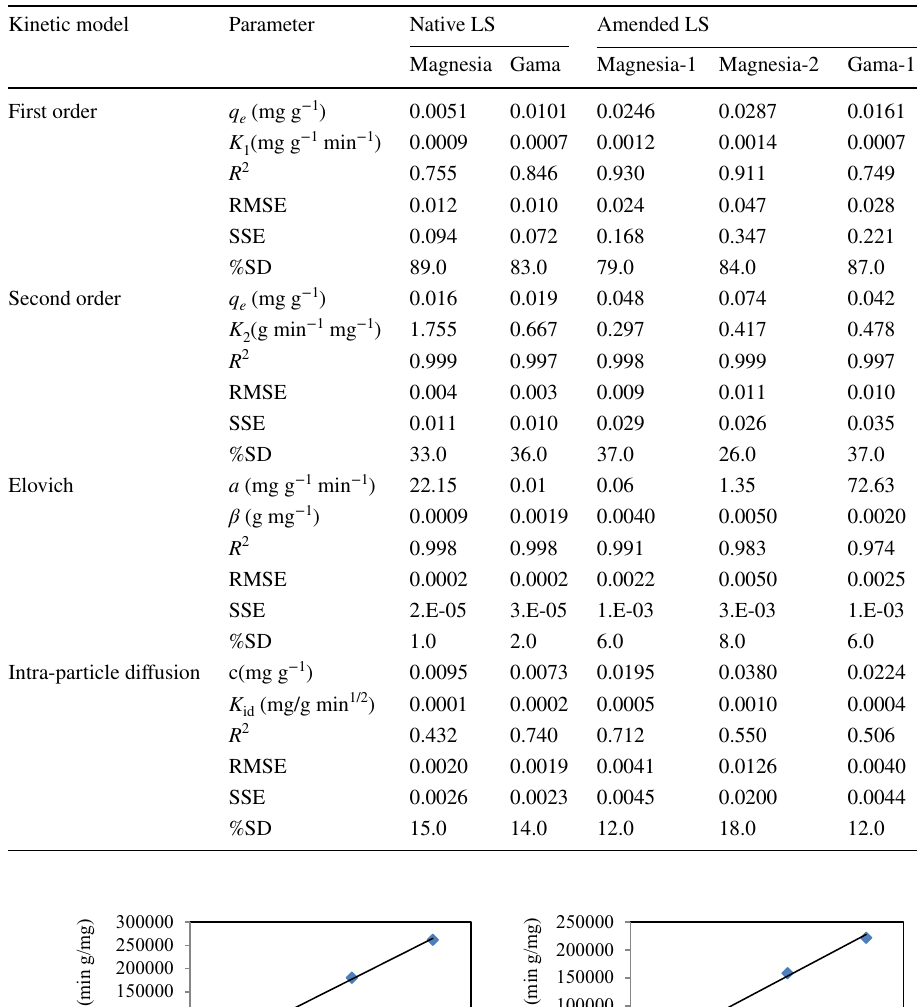
Fig. 6 Second-order lineariza- tion for F − adsorption onto a Magnesia b Gama c Magnesia-1 d Gama-1 LS